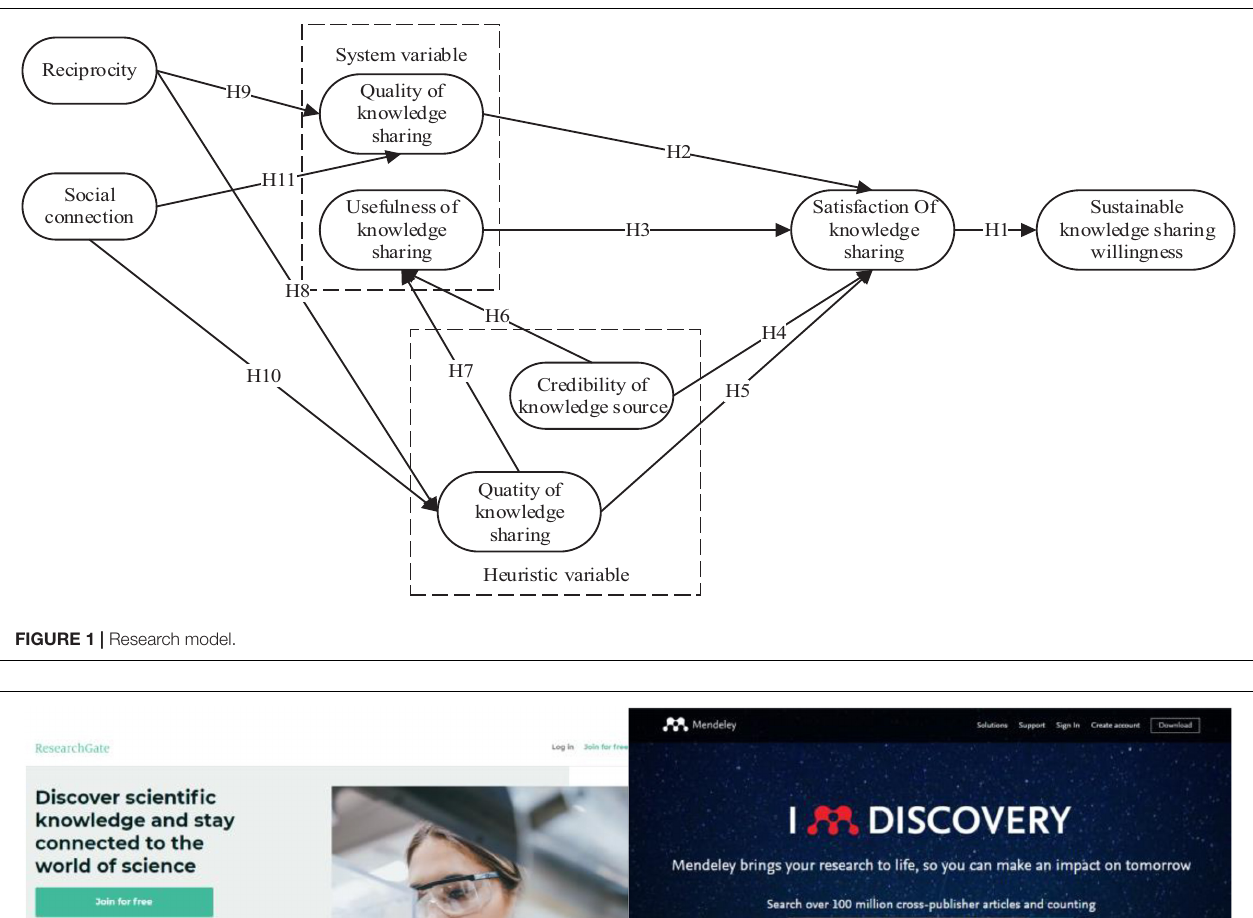
FIGURE 2 | Homepages of ResearchGate and